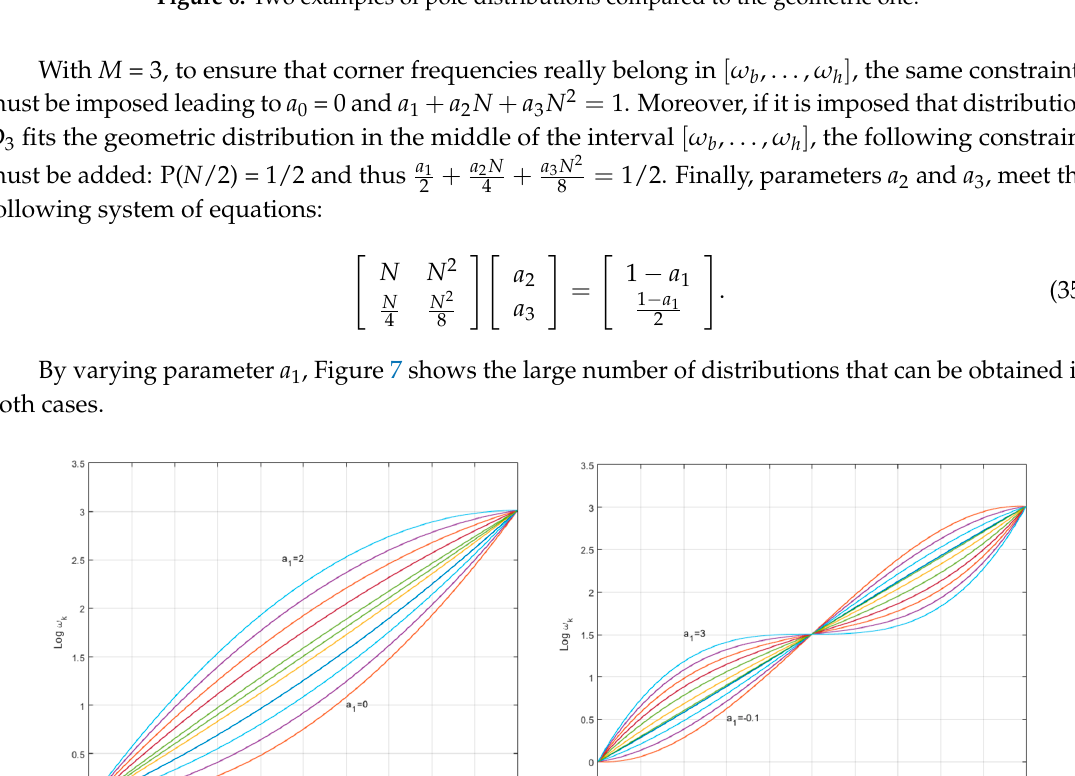
Figure 6. Two examples of pole distributions compared to the geometric one.